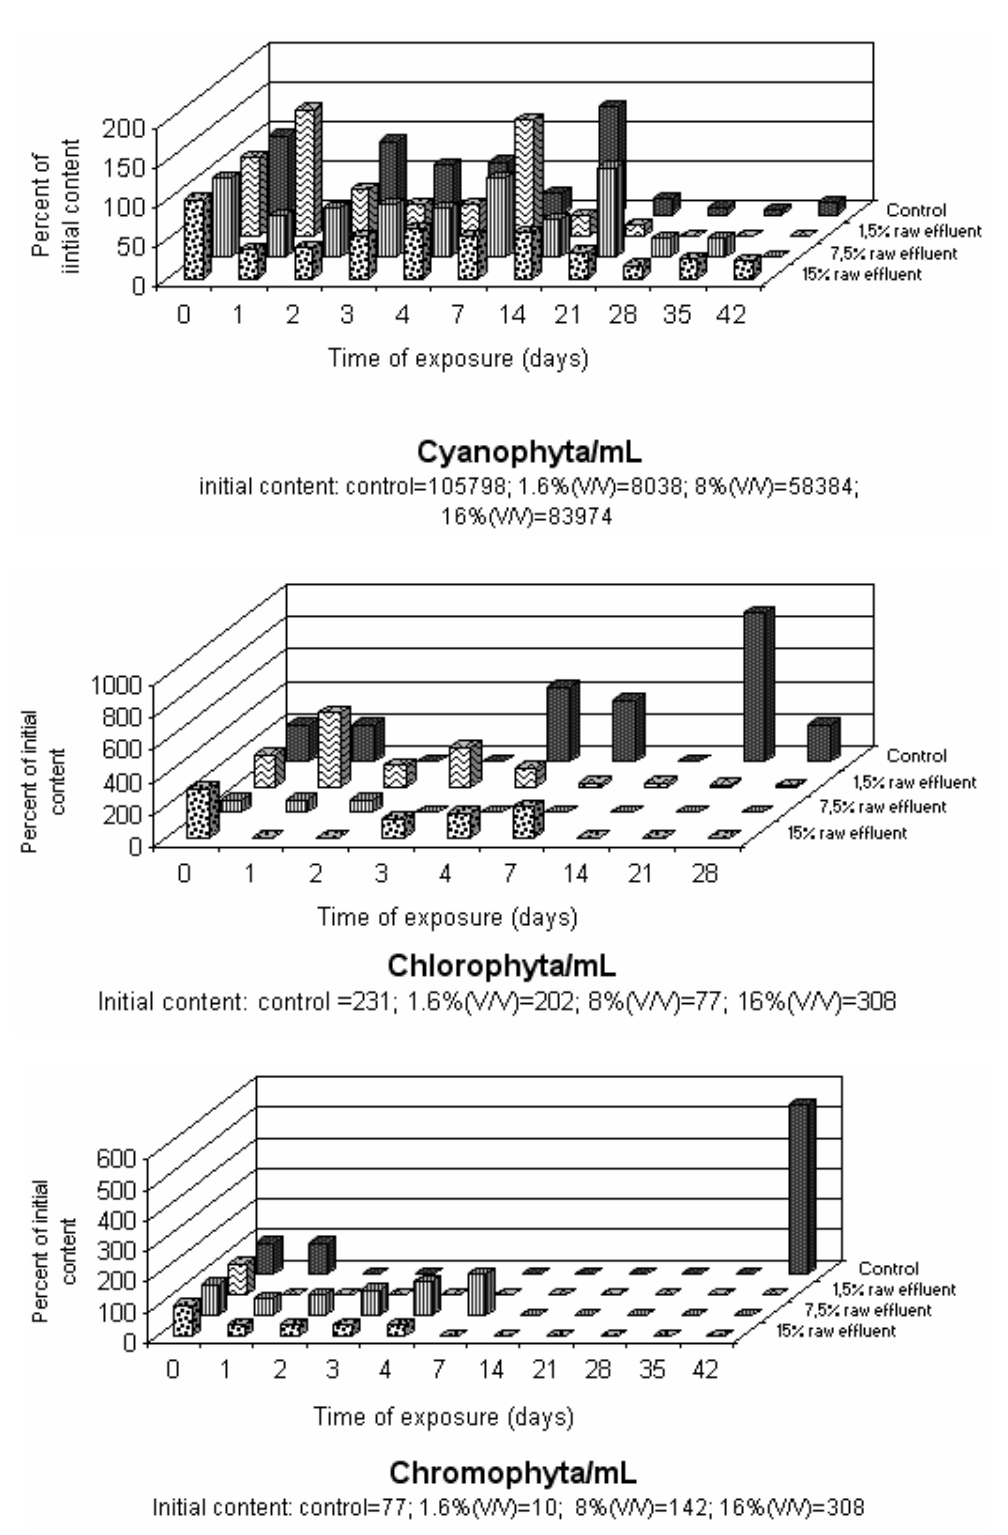
Figure 2: The effect of Pilcam effluent on the phytoplancton density from untreated and treated